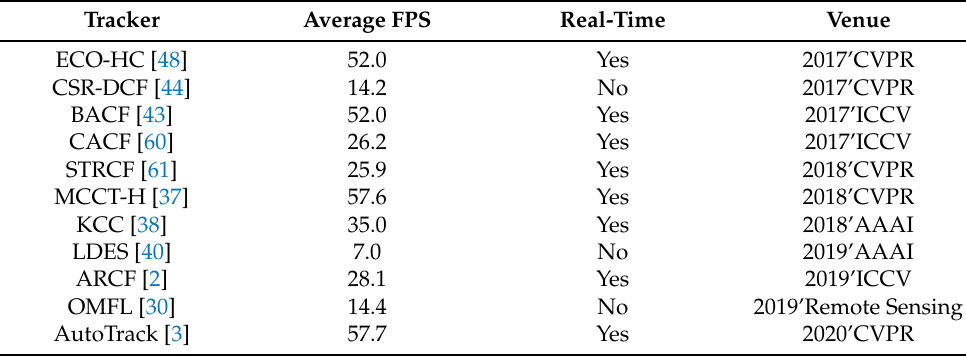
Table 1. Real-time performance comparison on the UAV123@10fps [45] benchmark. All results are generated solely by a desktop